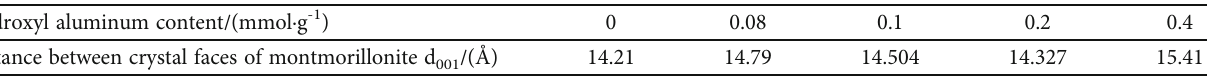
Table 4: Variations of the crystal face space of montmorillonite